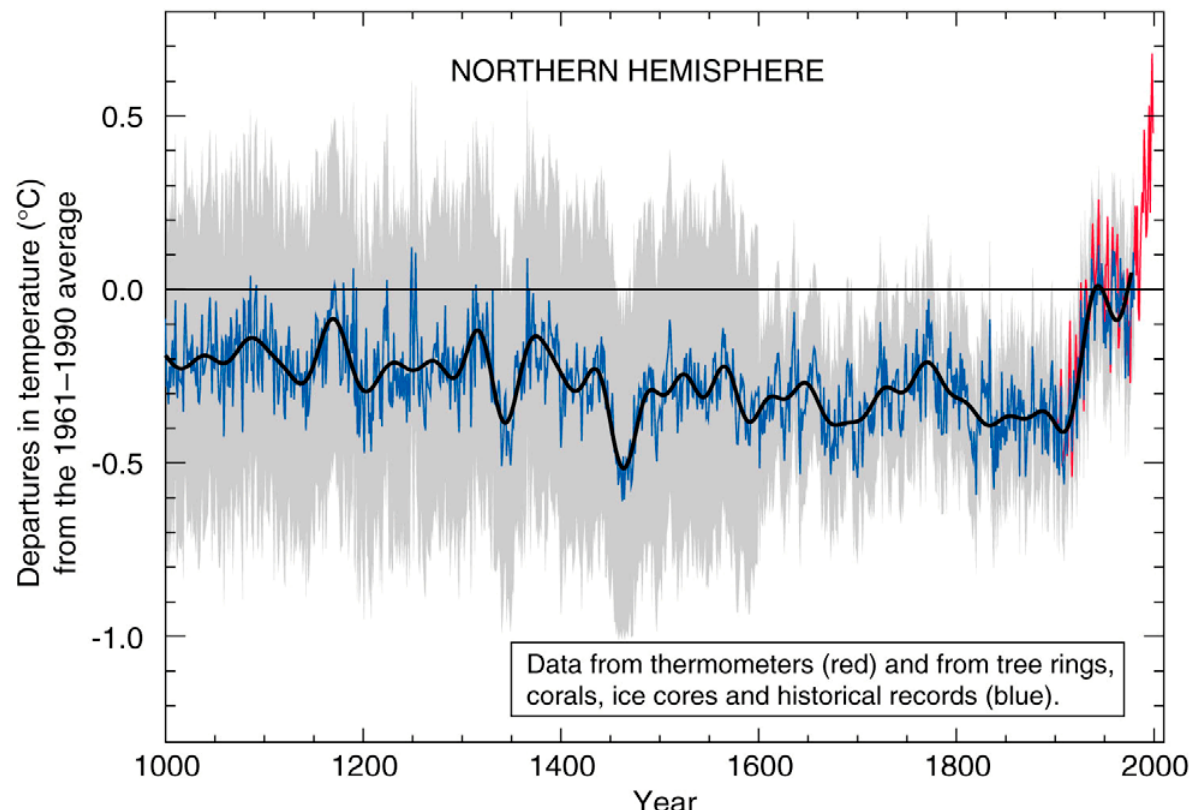
Figure 7. The Hockey Stick—time reconstructions (blue) and instrumental data (red) for Northern Hemisphere mean temperature. In both cases, the zero line corresponds to the 1902-80 calibration mean of the quantity. Courtesy Michael